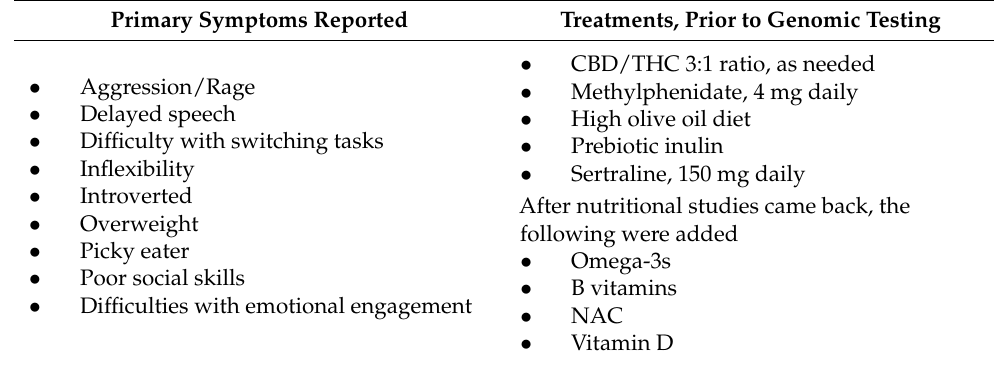
Table 1. Summary of the patient’s reported clinical symptoms and treatment regimen before ordering genomic CDS. The symptoms and therapeutic regimen are noted